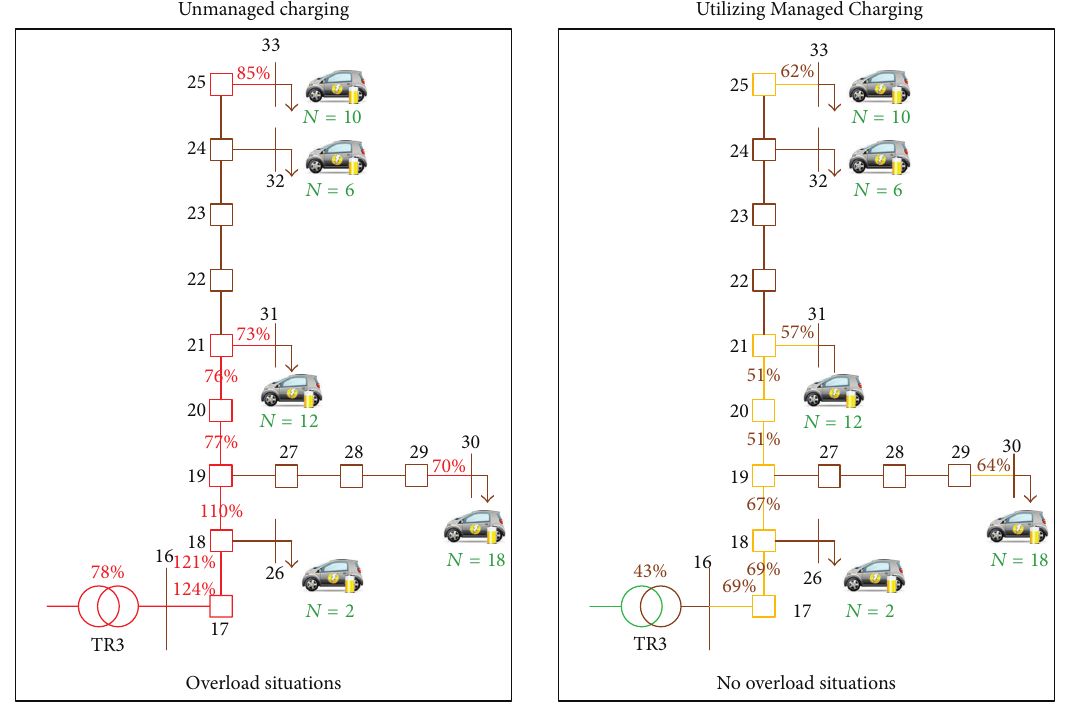
Figure 10: Charging scenario (overload situations).